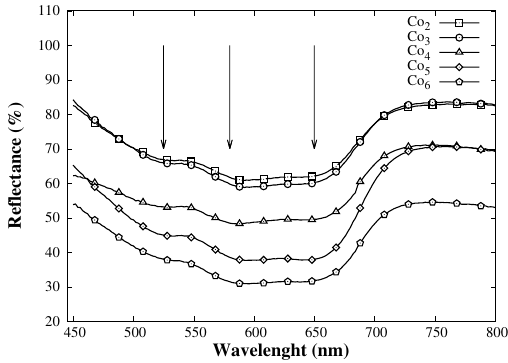
Figure 3. Diffuse reflectance UV–Vis of MCM-41–Co catalysts. The arrows point to the main absorption